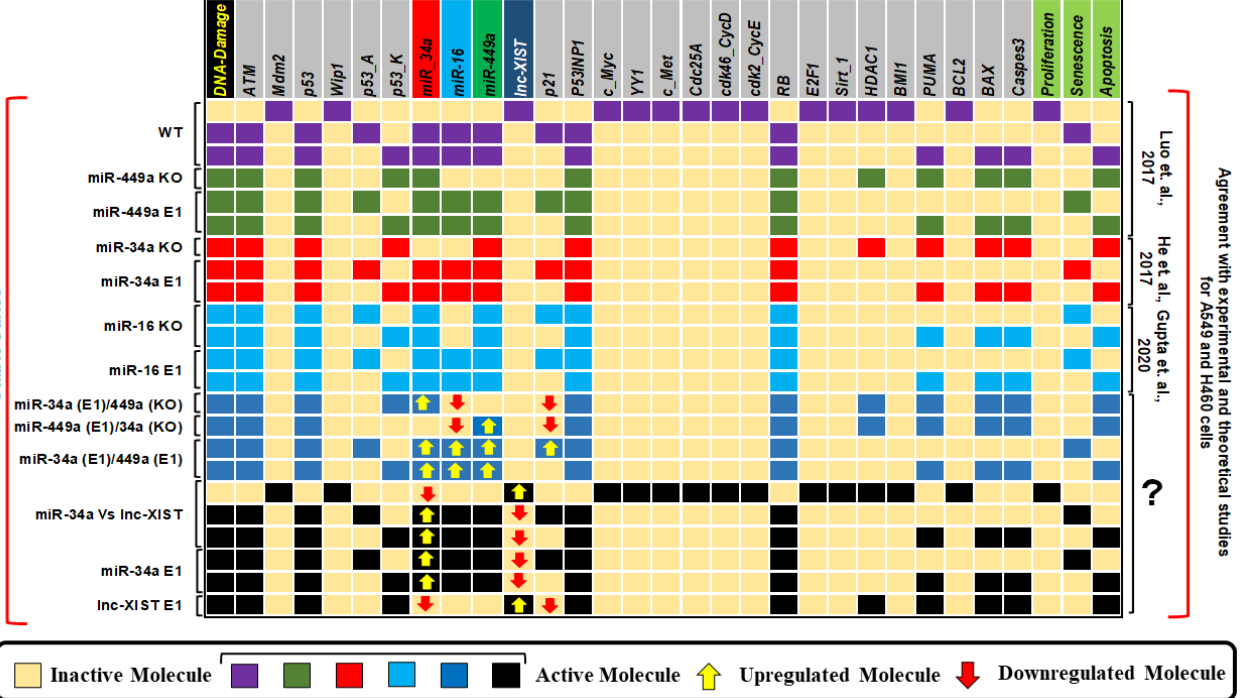
Figure 2. Model results. WT case states and results of Gain-of-Function (GoF) and Loss-of-Function (LoF) perturbations coordinate to the referential studies operated in this work. The question mark denotes model predictions. Ectopic expression (E1) describes gain of function and Knockout (KO) loss of function of the similar model component. Yellow cells denote inactivation (OFF), whereas colored cells such as: purple, green, red, light blue, dark blue and black denote activation (ON). The stable states were pinpointed for different networking scenarios: WT, miR-449a KO, miR-449a E1, miR-34a KO, miR-34a E1, miR-16 KO, miR-16 E1, miR-34a E1 along with miR-449a KO, miR-449a E1 along with miR-34a KO. Cells in dark blue color and black color that describe the model predictions and indicated by the question mark such as mention previously, in this way, miR-34a Vs lncRNA XIST, Negative correlation between miR-34a and lncRNA XIST in DNA damage response, miR-34a E1, and lncRNA XIST E1. Red arrows designate down-regulation, whereas yellow arrows convey up-regulation. The left-most queue exhibits the input DNA Damage and the right-most queues demonstrate the model developments: proliferation, apoptosis, and senescence. Per line symbolizes a unique fixed point be compatible with the